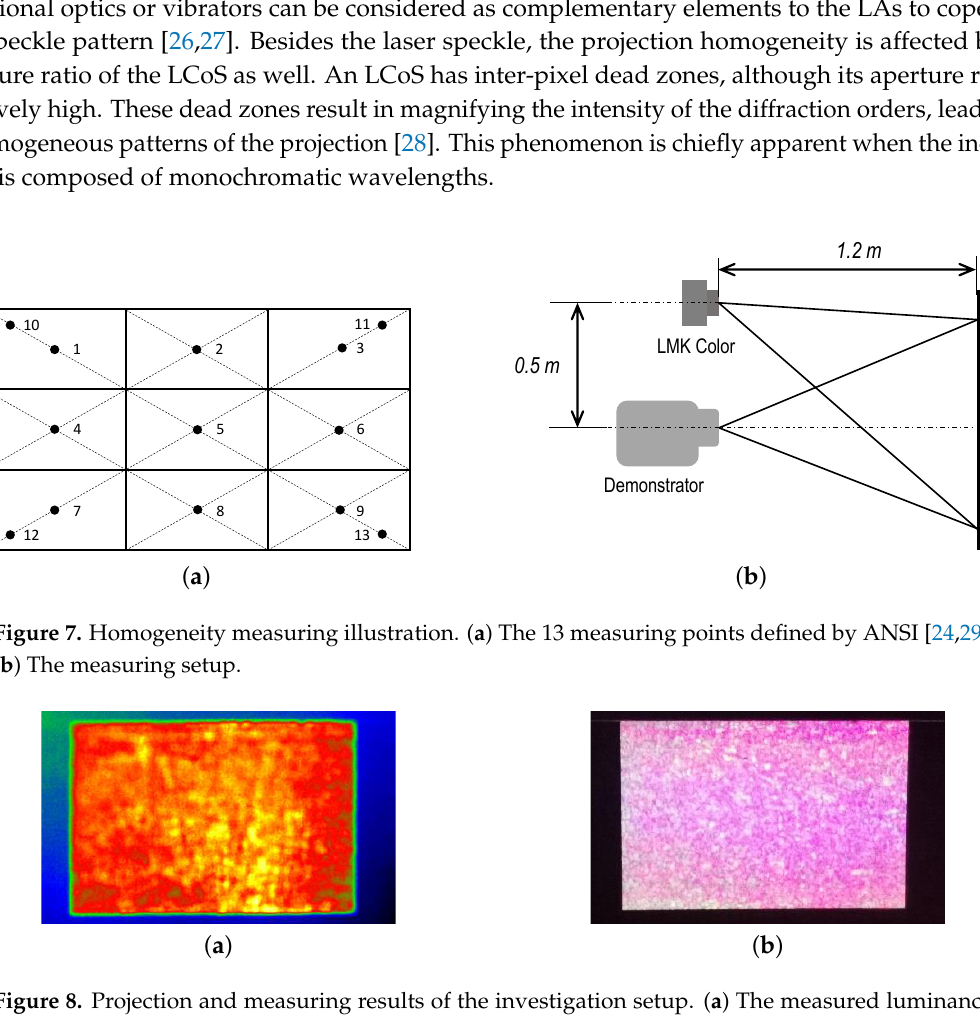
Figure 8. Projection and measuring results of the investigation setup. ( a ) The measured luminance image from the LMK Color 5; ( b ) The real projection